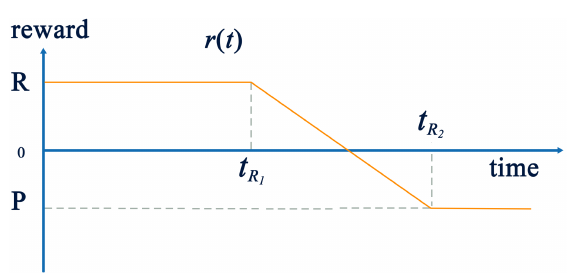
Figure 2. A reward